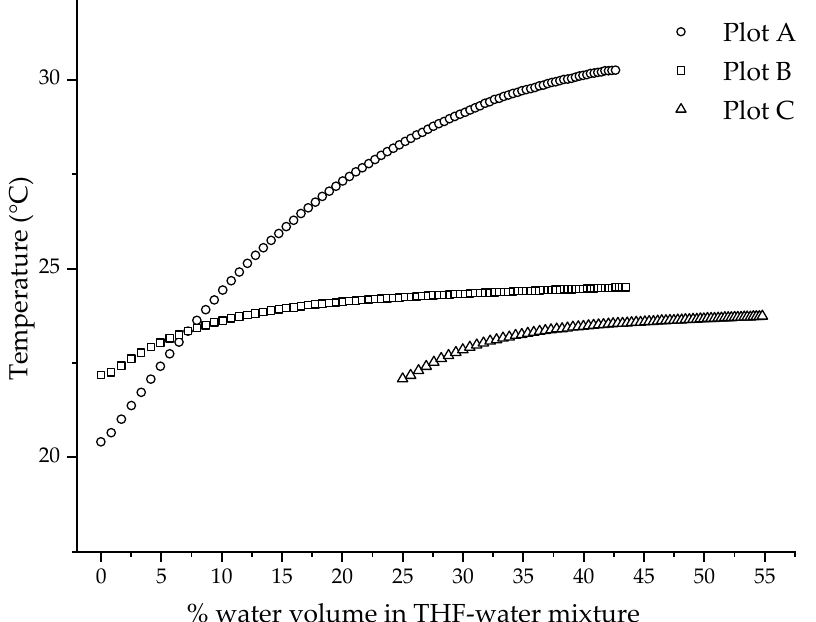
Figure 8. Temperature profile for the addition of water obtained by making three different changes to experimental set-up.